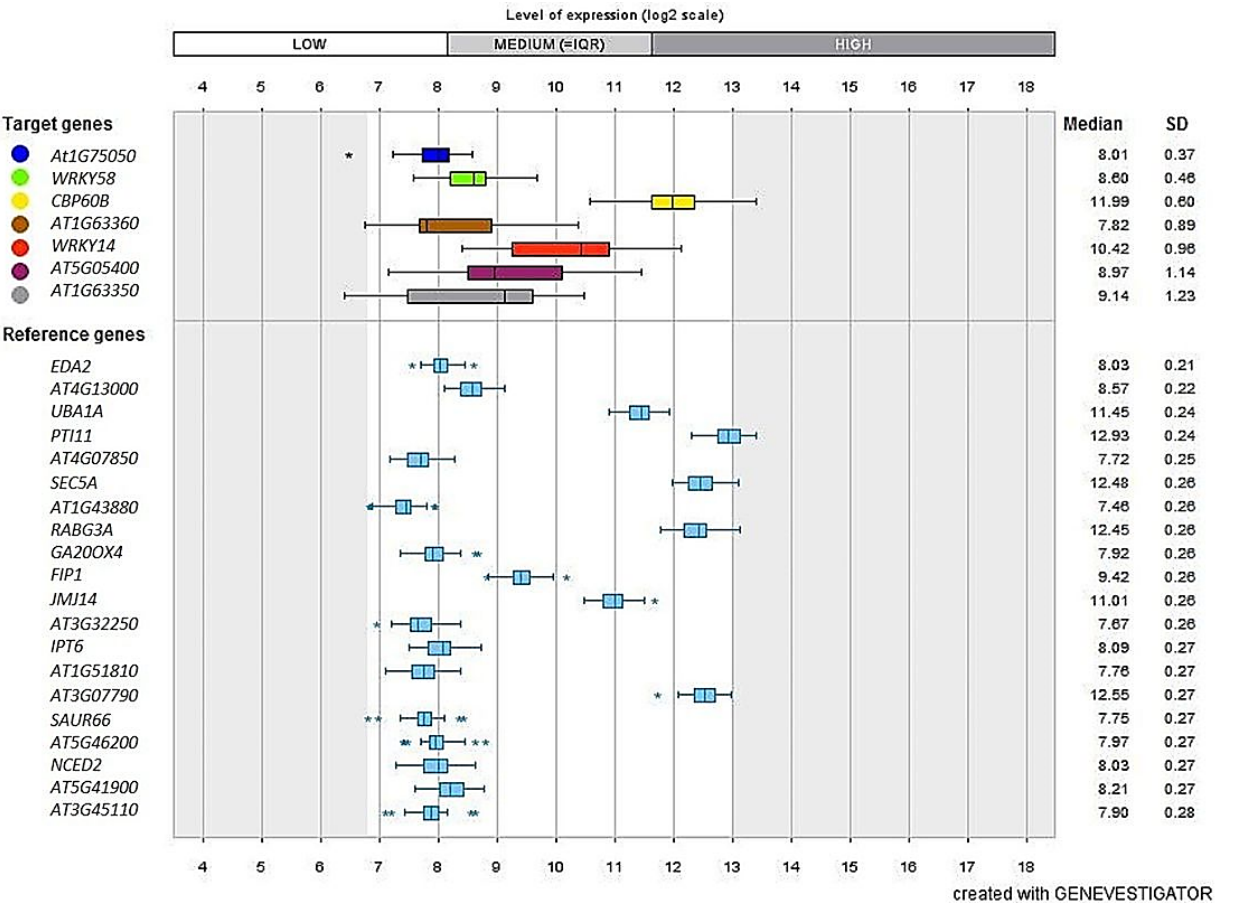
Figure 6. A total of 20 Arabidopsis reference genes showed correspondence in the expression levels with that of seven selected target genes as obtained after infection of lentil with Rhizoctonia . * and ** shows that the expression is significant ( p ≤ 0.05) and highly significant ( p ≤ 0.01),